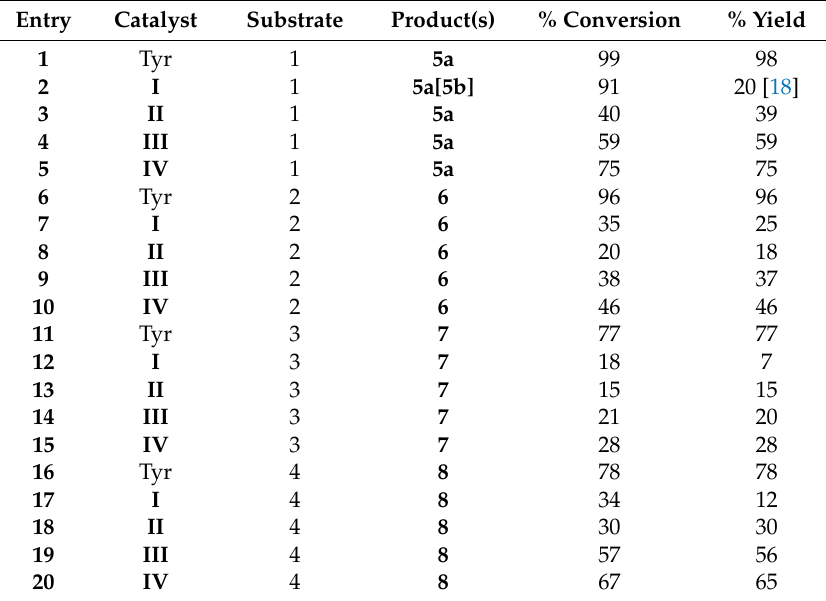
Table 5. Oxidation of Phenols 1 – 4 with Native Tyrosinase and Catalysts I – IV a .